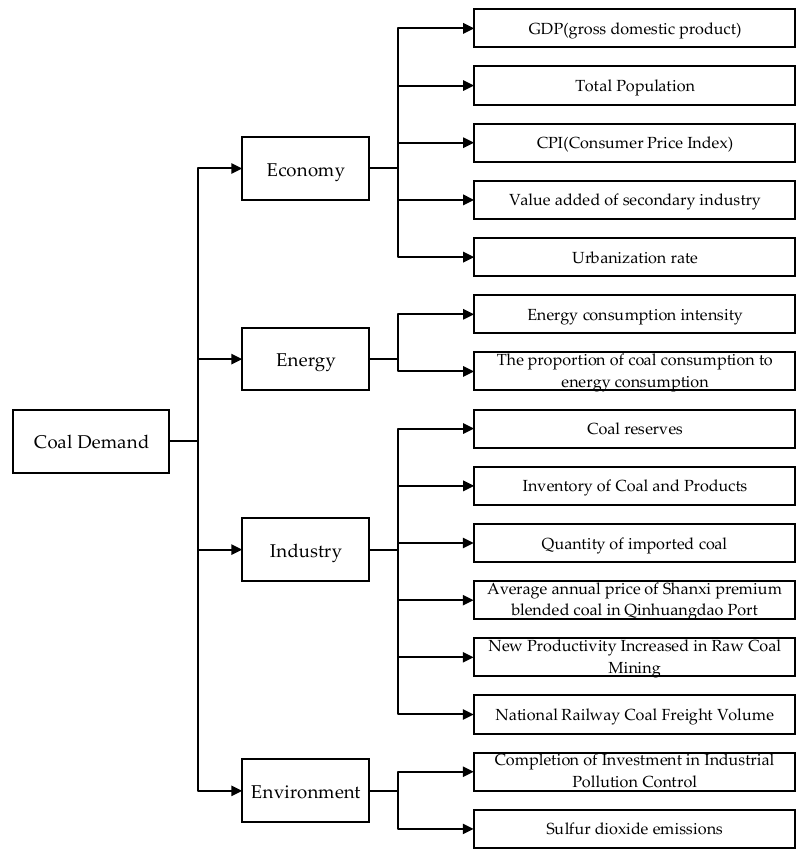
Figure 1. Influence factors system for coal demand forecasting.